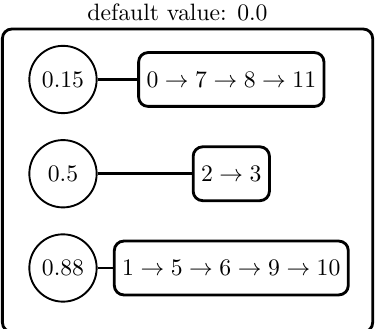
Figure 13. Final approximation of φ obtained in the third iteration. The loss of information in relation to the original potential is now 0.021613. The next iteration must select between only two reductions , as shown in Table